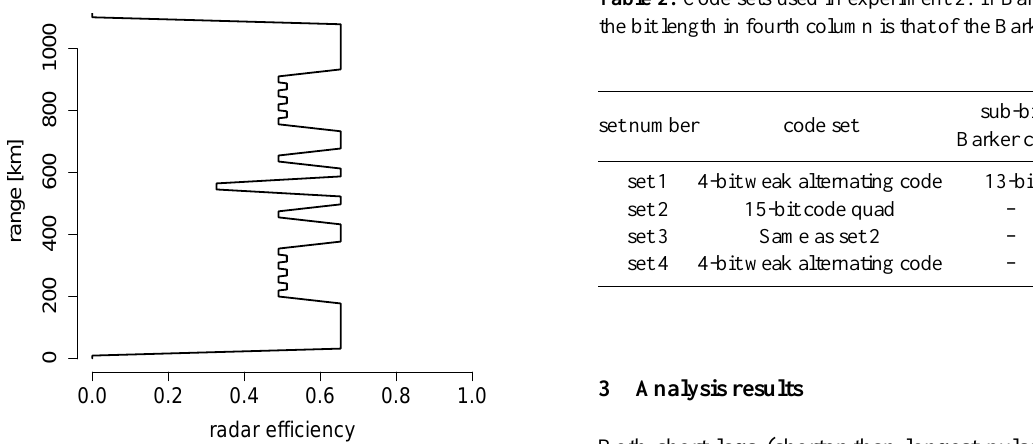
IPPs are 1104, 1450, 1750, 2740, 1004, 1350, 1650, 2640, 1204, 1550, 1850, 2540, 1304, 1650, 1880 and 2934 µs. Real